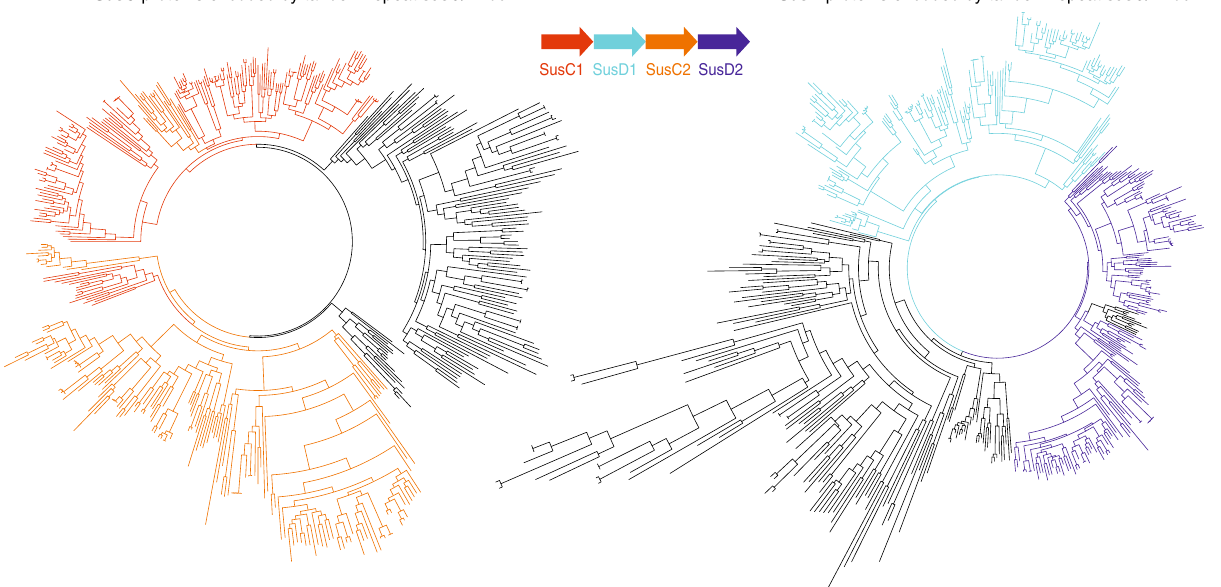
Fig. 3 Phylogenetic trees of SusC and SusD proteins encoded by tandem-repeat susC/D loci. SusC and SusD form color-coded congruent clades in the two phylogenetic trees. Each member of each clade has same genomic position in the repeat, revealing a strict synteny within each trsusC/D